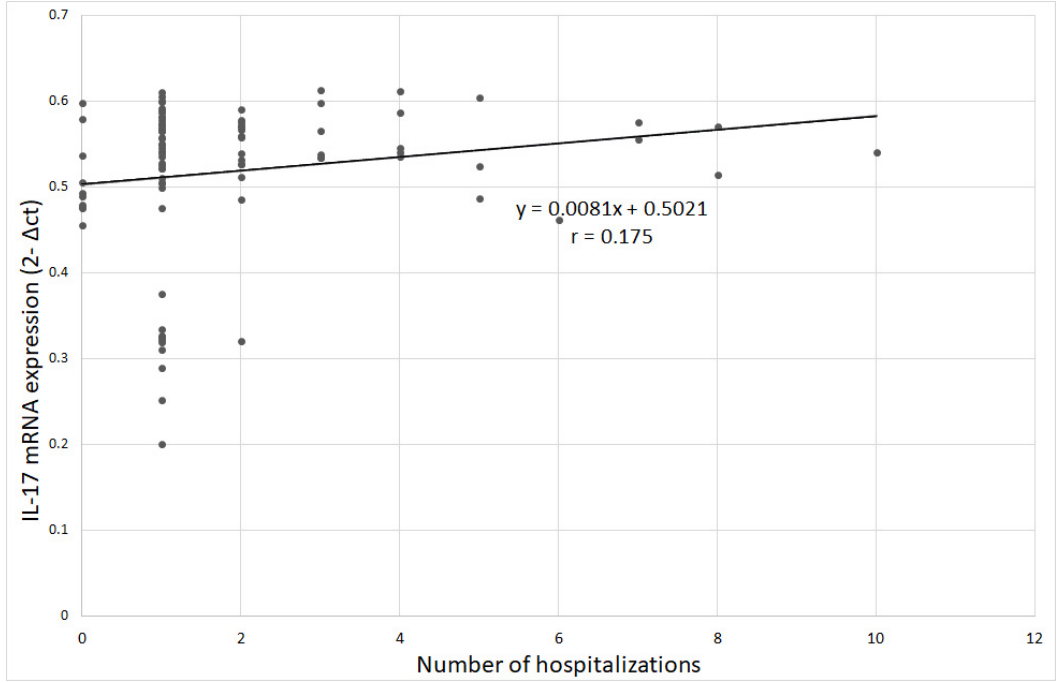
Figure 9. Correlation between IL-17 gene mRNA expression and number of hospitalizations;. r-Pearson’s linear correlation coefficient.